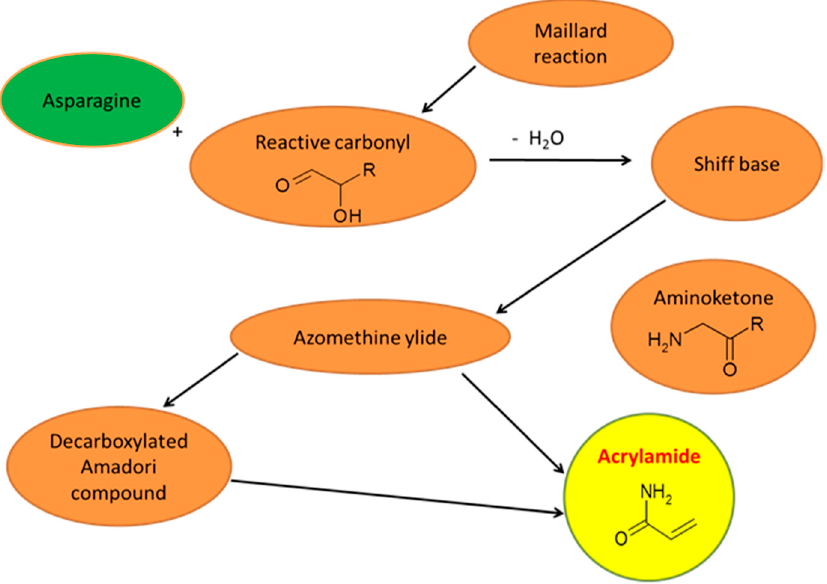
Figure 1. Simplified mechanism of acrylamide formation by Maillard reaction.